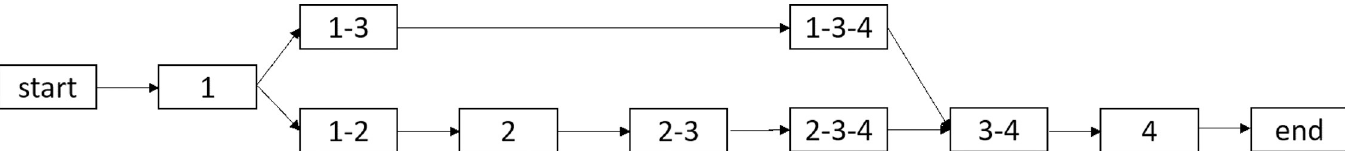
Fig 2. An example splicing graph for model simplification. The ‘start’ and ‘end’ nodes are pseudo nodes. In this example, there are four exons represented by 1, 2, 3, and 4. Each node represents a possible read type, and nodes are connected in a way that a node shares the same starting exons with a node to its left and shares the same ending exons with a node to its right. An arrow connecting two nodes points to the end direction. A4 in S1 File delineates the steps of how to construct a splicing graph.